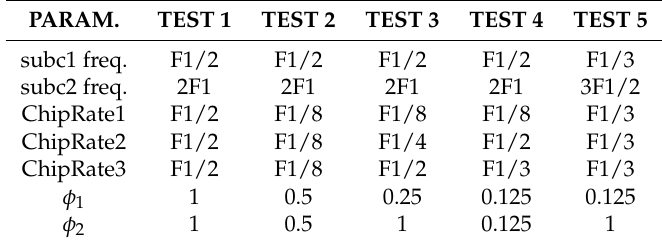
Table 2. Test cases configuration